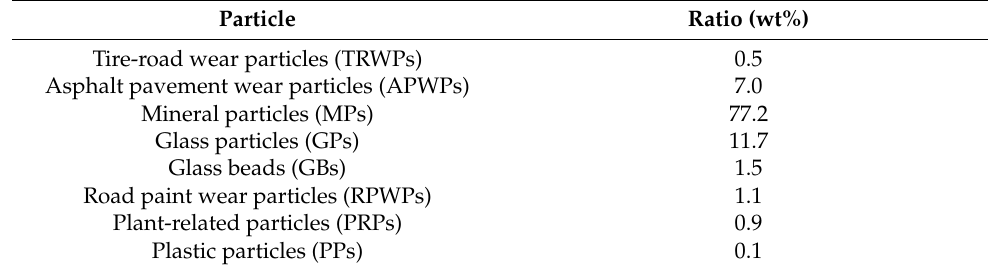
Table 1. Particle components of the RD1 sample (212–500 µ m).